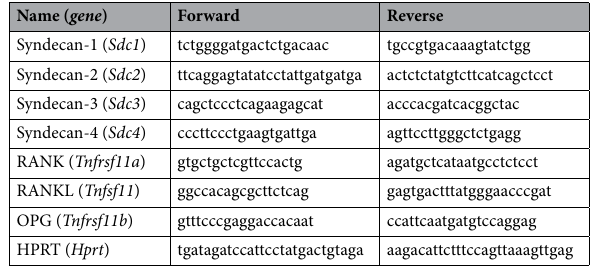
Table 2. Primers used for quantitative real time